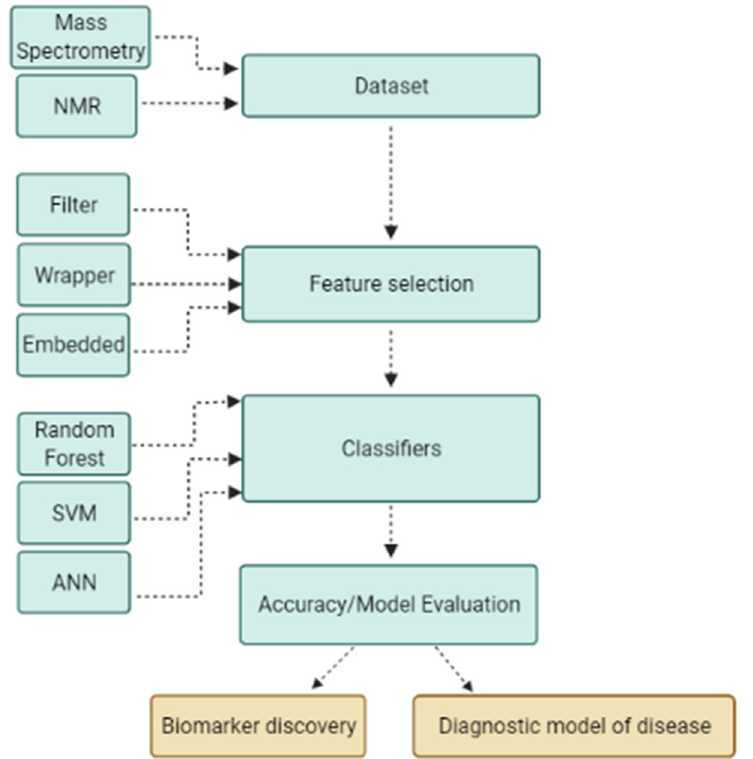
Figure 2. Machine learning application using a stepwise process for biomarker discovery and diagnostic modeling. The machine learning process begins with input of dataset generated by various platforms; data are then subjected to a feature selection algorithm to reduce dimensionality and obtain optimal subsets of features to build a robust classification model and to discover biomarkers.